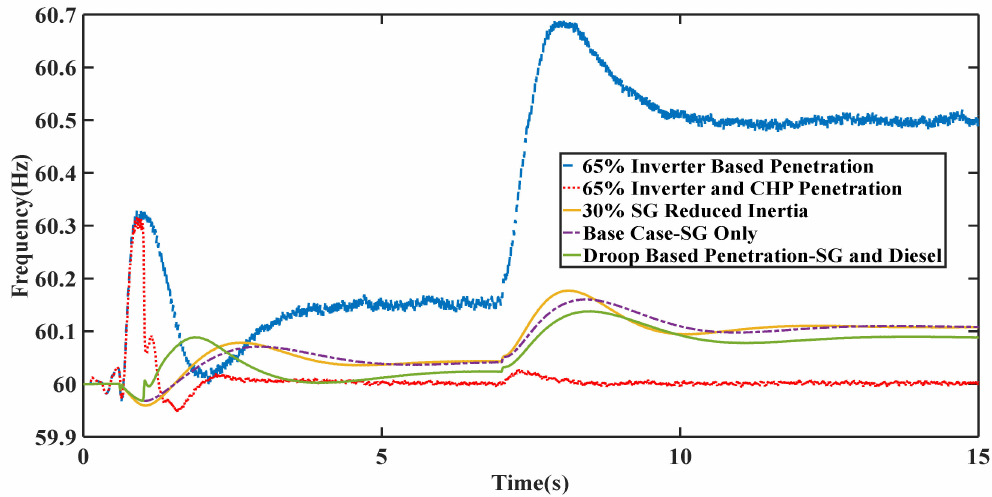
Figure 15. Frequency deviation due to 10% load disconnection in the presence of different DER contributions.